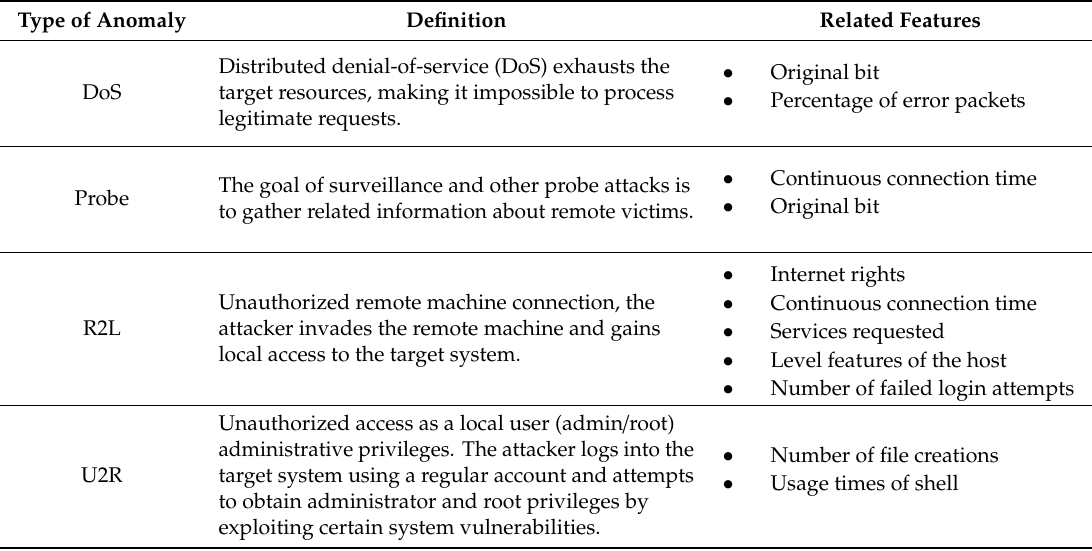
Table 1. Four classified categories of anomalous